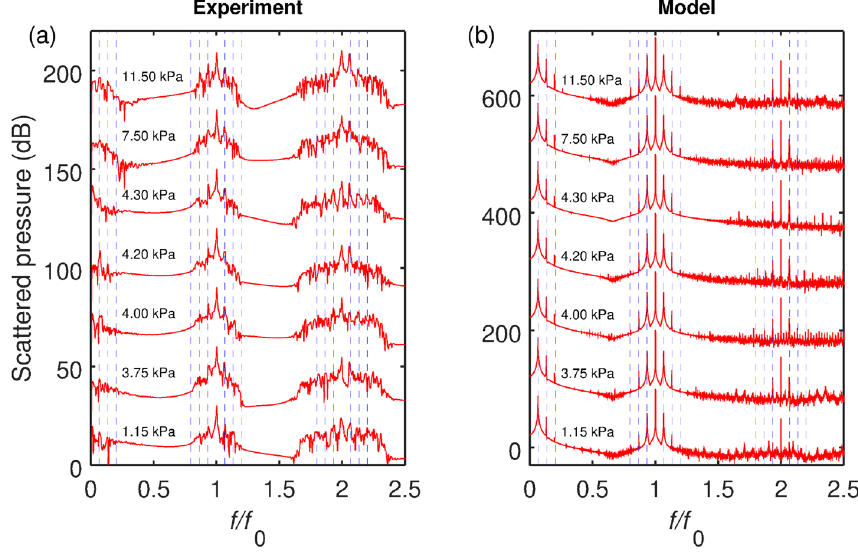
Figure 2. ( a ) Experimental spectra of a cluster of gas bubbles in water insonated with the 24.6 kHz 1.15 , 3.75, 4, 4.2, 4.3, 7.5 and 11.5 kPa. The frequency sinusoidal signal of increasing pressure amplitude α = axis is normalised with frequency f 0 of the driving field. The detectable response frequency resolution is 4 1.34 10 � f / f 0 . The scattered pressure values (in dB) are shown along the vertical axis with the vertical − = × offset of 30 dB between spectra. ( b ) Calculated spectra of a single gas bubble with 1.95 mm radius at the same driving pressure frequency and amplitudes as in the experiment. The vertical offset between individual spectra is 100 dB. In both panels, the vertical dashed lines mark the peaks at the natural frequency and its ultraharmonics (the left parts of the spectra) as well as the frequencies of the sideband peaks around the fundamental and second harmonic frequency of the driving